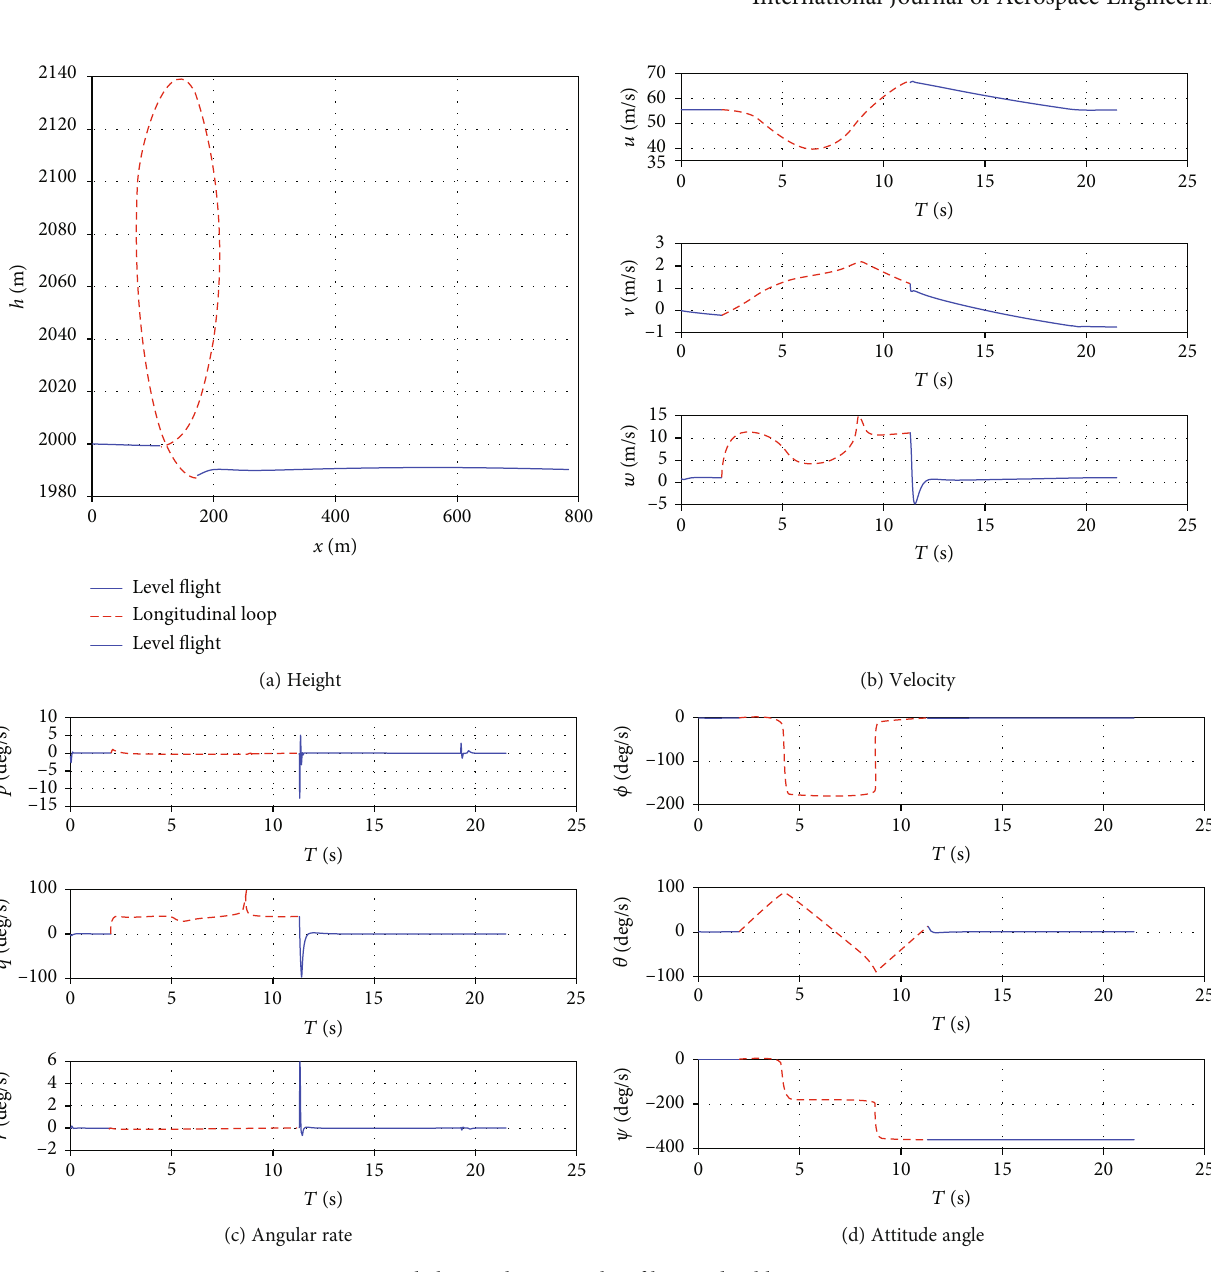
Figure 11: Flight simulation results of longitudinal loop